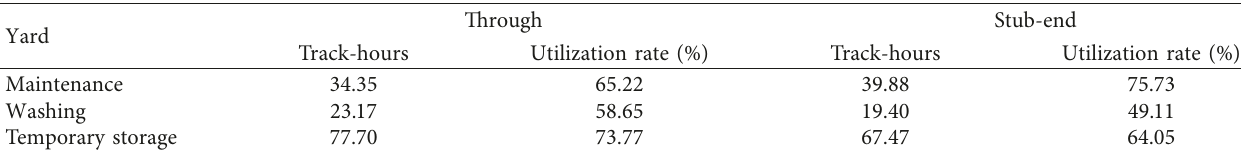
Table 10: The track utilization rate of each yard generated by original